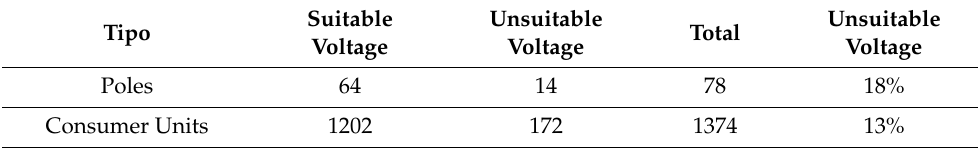
Table 6. Report extracted results for feeder- β . Tipo